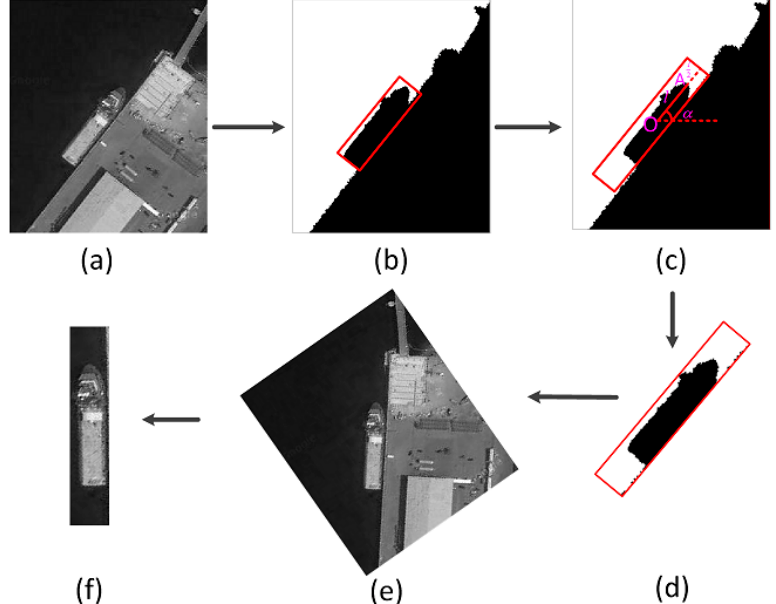
Figure 3. Process of acquiring identifiable candidate regions. ( a ) Part of the input image; ( b ) Suspected candidate regions (SCR) in the binary image; ( c ) Expansion process of the SCR; ( d ) New rectangle after expansion; ( e ) Part of the input image rotated by α ; ( f ) New candidate region of the bulge.